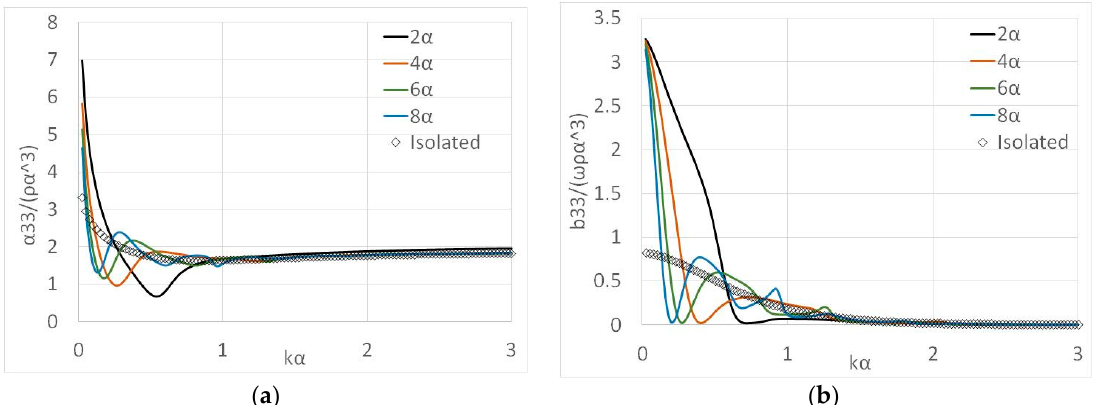
Figure 5. Hydrodynamic coefficients of a floating cylindrical floater placed in front of an orthogonally shaped (right angle) breakwater using the method of images for L 1 = L 2 = 2 α , 4 α , 6 α , 8 α : ( a ) heave added mass due to motion of the body in heave; ( b ) heave damping due to motion of the body in heave. The results are also compared with the corresponding values of the same isolated floater (i.e., without the presence of the walls).